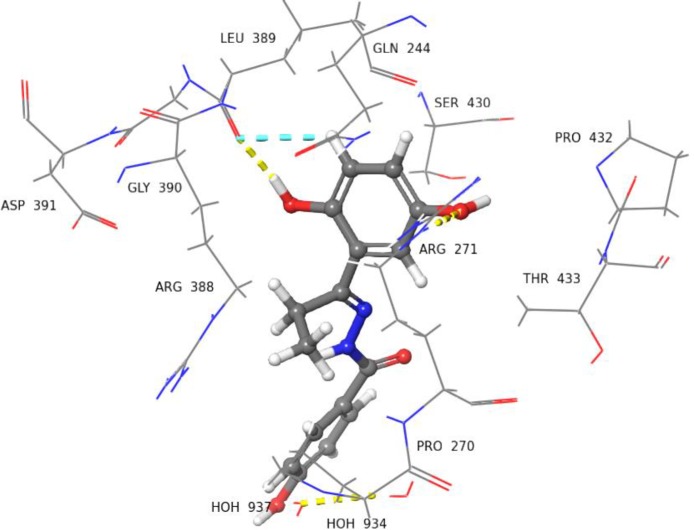
3D Representation of docked pose of compound 29 (IC50 = 173.0 ± 1.4 μM).The ortho substituted OH group is interacting with the Leu389 via H-bond (yellow dotted lines), and the phenyl ring hydrogen is interacting with Leu389 via H-bond (blue dotted lines). The meta substituted OH group is interacting with Arg271 via H-bond.